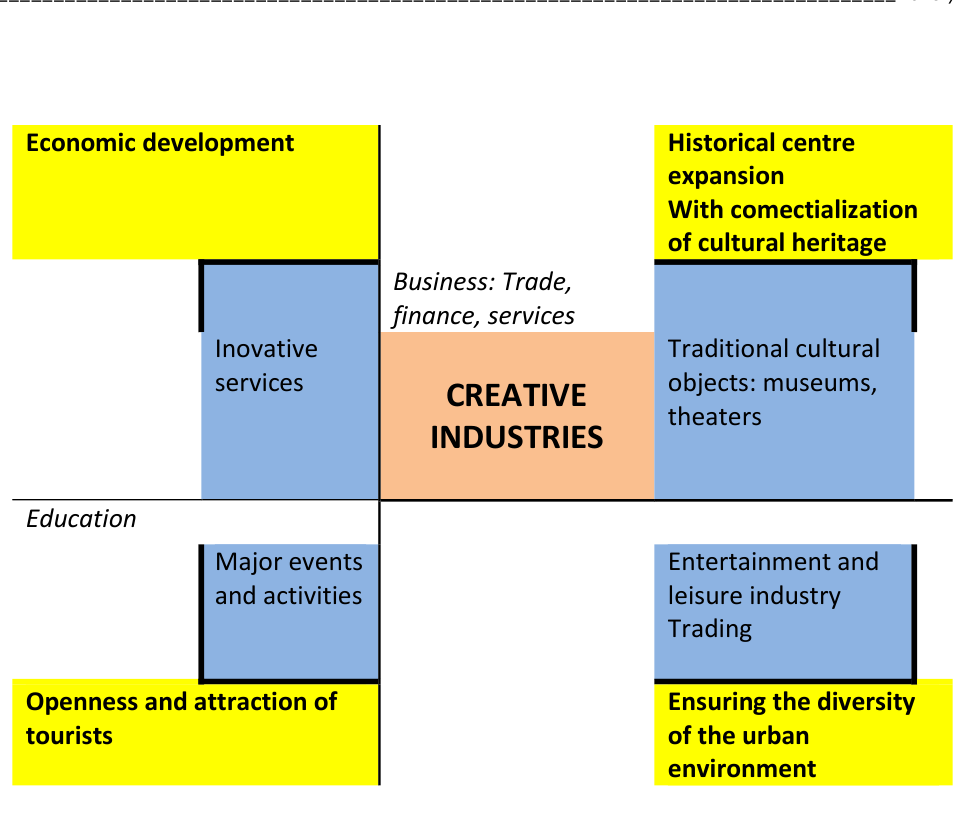
Fig. 1. Strategic interaction of creative industries (developed by the